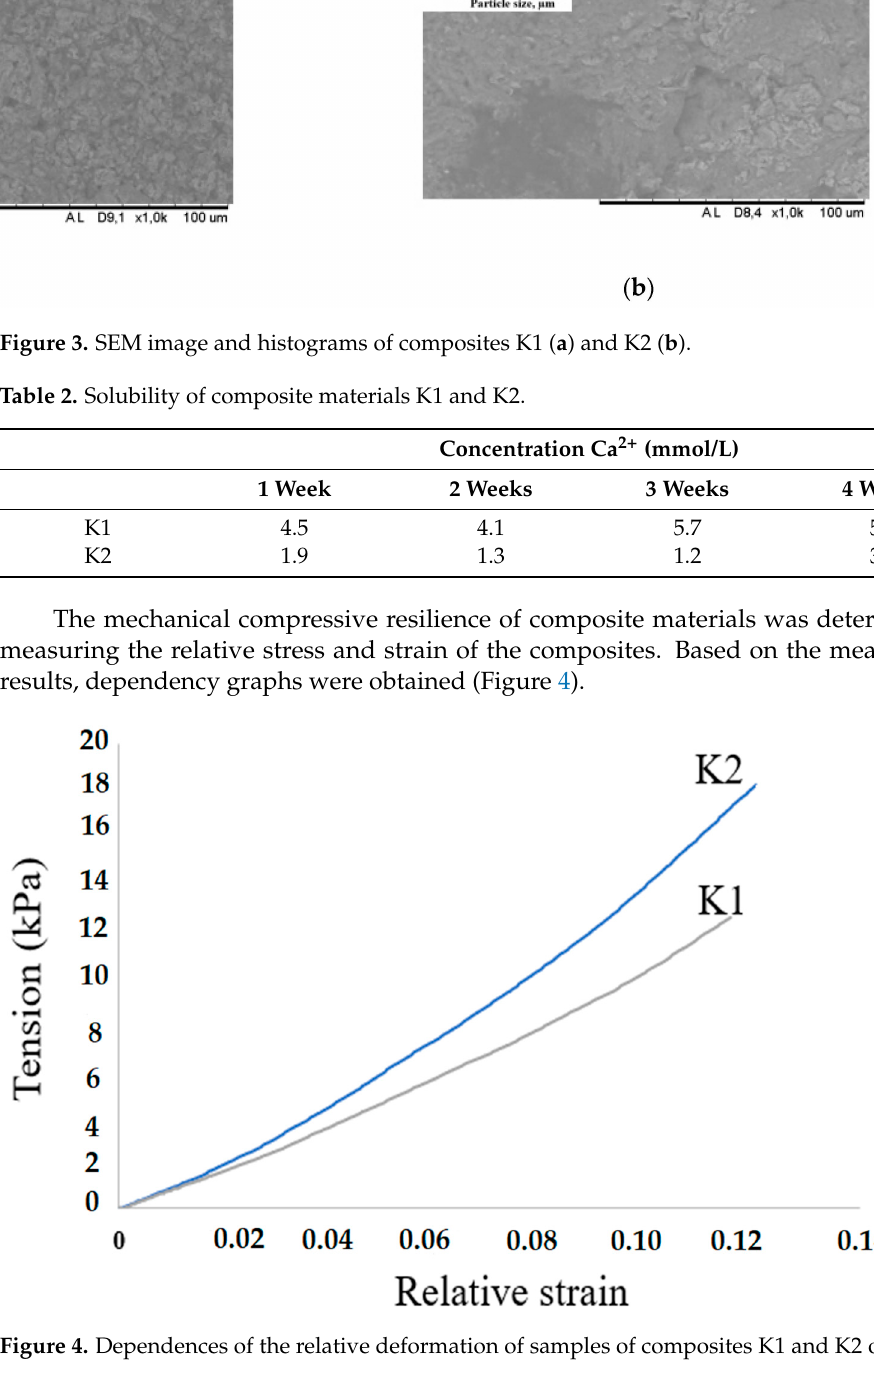
Table 3. Modulus of elasticity of composite materials K1 and K2.